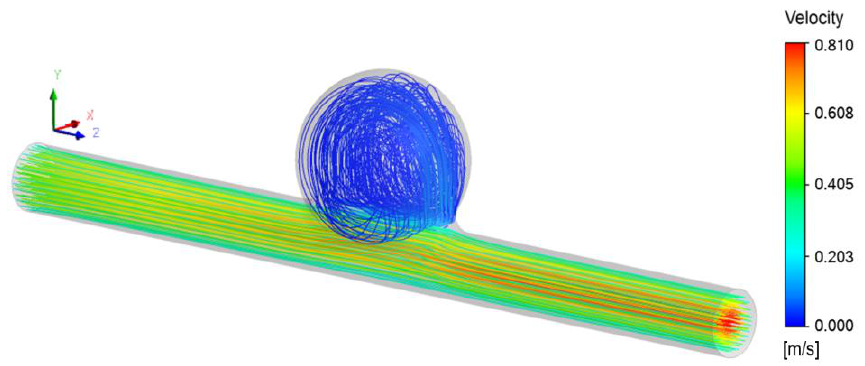
Figure 7. Streamlines for Newtonian flow and Re = 500.